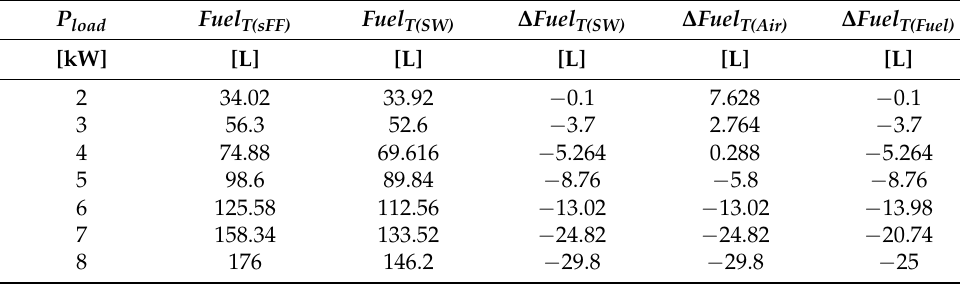
Table 3. Fuel economy for k fuel =